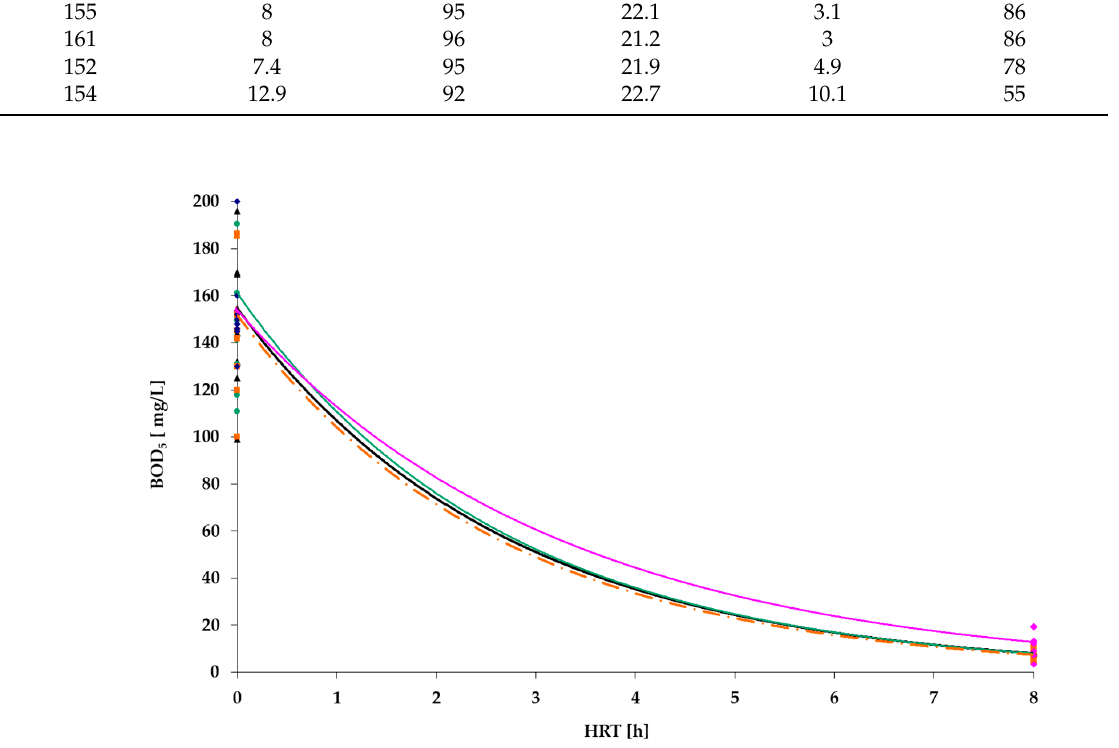
Figure 8. Ammonium removal dynamics if: floating carrier is 10% of reactor volume (black); 20% of tank volume (green); 30% of tank volume (orange); no carrier in the reactor (magenta).